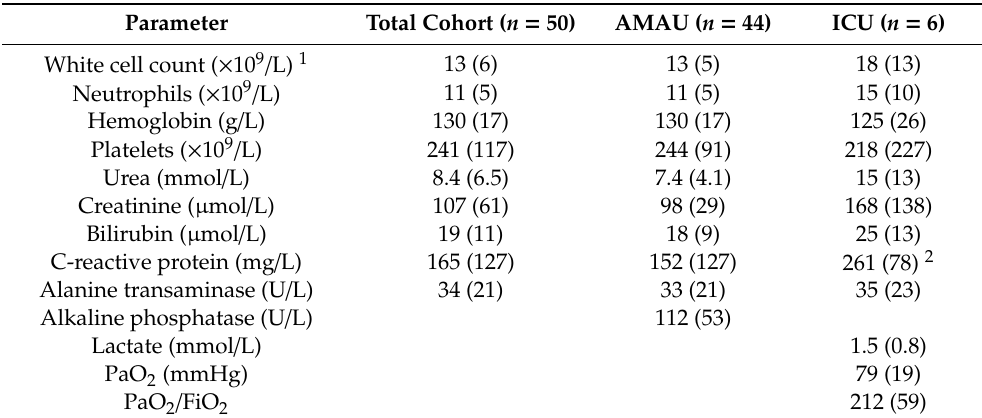
Table 2. Participant hematological parameters.